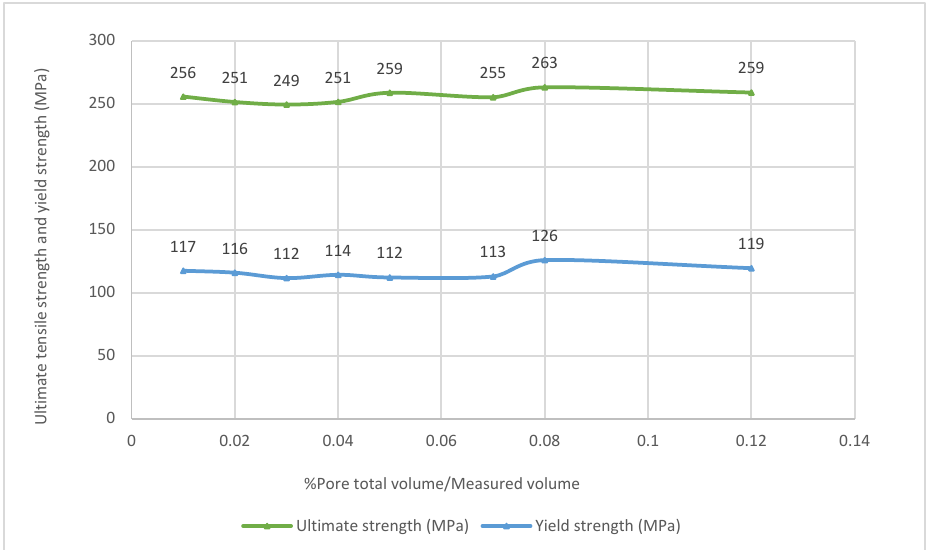
Figure 13. Ultimate tensile strength and yield strength versus the percentage pore total vol- ume/measured volume.